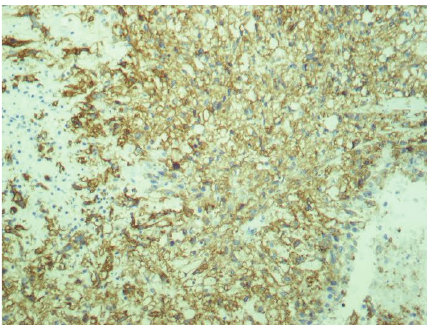
Figure 4: Immunohistochemical stain of angiosarcoma of the spleen (CD34 × 400).